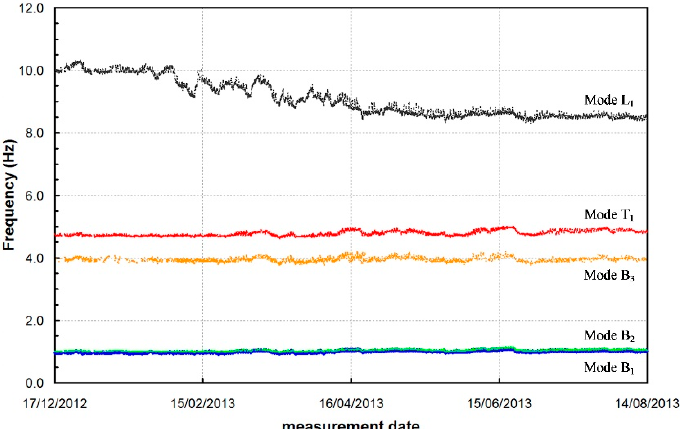
Figure 9. Gabbia Tower in Mantua Variation of identified natural frequencies (Figure 6) [19]. Infrastructures 2020 , 5 , x FOR PEER REVIEW